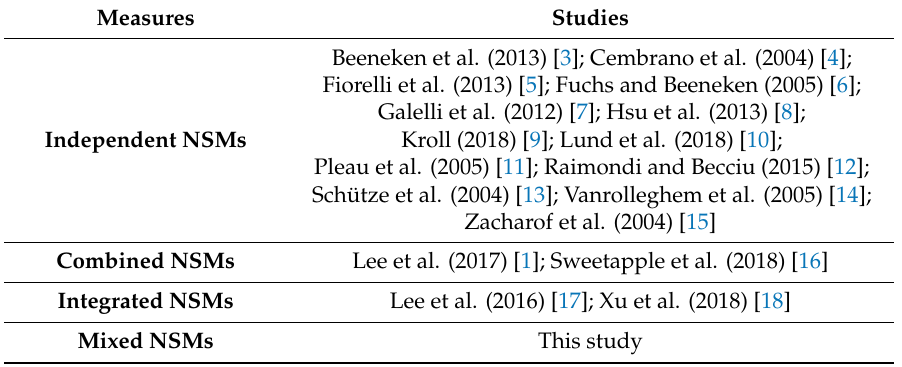
Table 1. Classification of measures with real-time control (RTC) in urban drainage systems (UDSs). NSM, non-structural